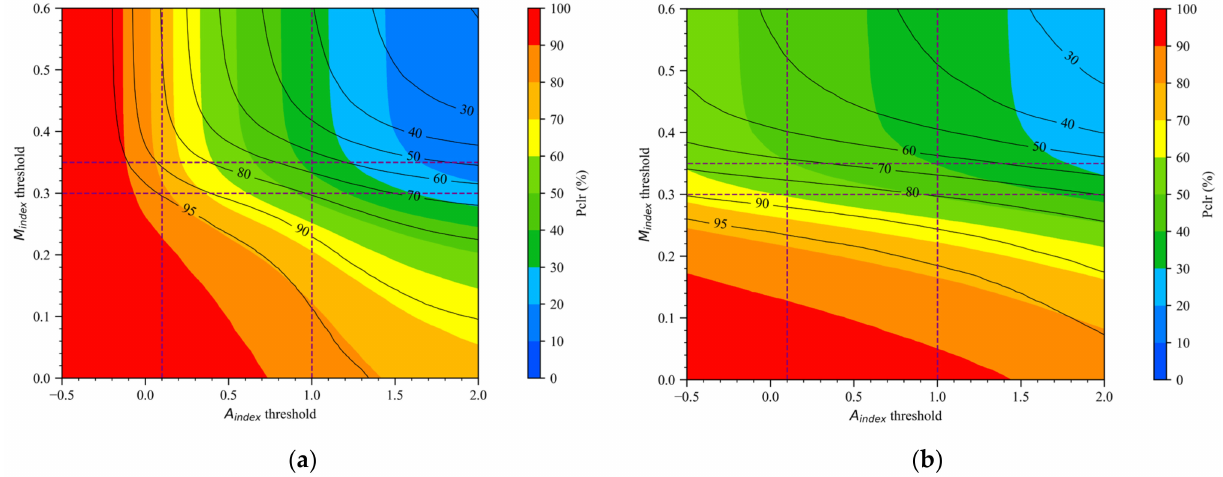
Figure 5. Detection rate of cloudy data (contours) and rejection rate of clear-sky data (colors) with ( a ) and without ( b ) channel 4 under different cloud index thresholds from 1 to 31 August 2019. The horizontal axis is the threshold of the AMSU-A cloud index, and the vertical axis is the threshold of the MHS cloud